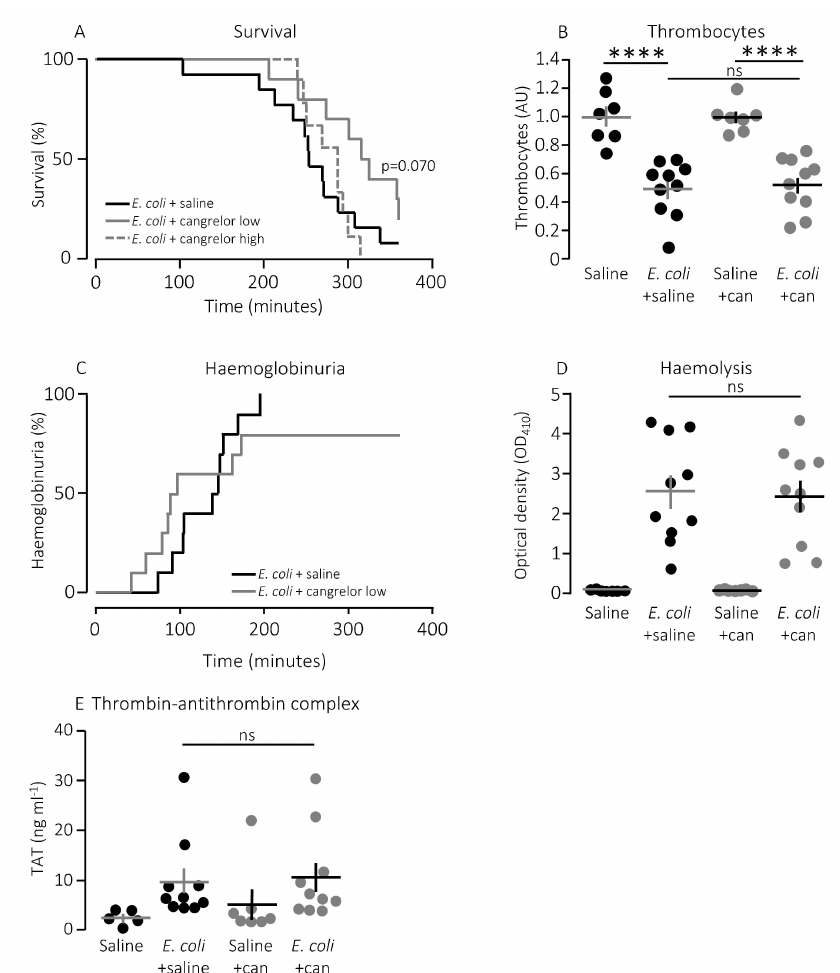
Figure 5. The effect of P2Y 12 receptor antagonist cangrelor (can) in mice with sepsis. ( A ) Mice with bacteraemia receiving continuous infusion of either saline ( n = 13) or cangrelor (8.6 µ g / h, n = 10 or 86.0 µ g / h, n = 9) for up to 6 h. The mice subjected to bacteraemia received 30 x 10 6 E. coli (WAM1824) iv. Data are shown as Kaplan–Meyer plot. ( B ) The relative number of thrombocytes 2.5 h after injection of 30 × 10 6 E. coli iv (saline n = 7, E. coli + saline n = 10, saline + cangrelor (8.6 µ g / h) n = 7, E. coli + cangrelor (8.6 µ g / h) n = 10) ( C ) development of haematuria in mice exposed to 30 × 10 6 E. coli for up to 6 h and infused with either saline ( n = 13) or the P2Y 12 receptor antagonist cangrelor (8.6 µ g / h, n = 10) for op to 6 h. ( D ) Degree of intravascular haemolysis after exposure to 30 × 10 6 E. coli for 2.5 h (saline n = 7, E. coli + saline n = 10, saline + cangrelor (8.6 µ g / h) n = 7, E. coli + cangrelor (8.6 µ g / h) n = 10). ( E ) The intravascular formation of thrombin–antithrombin complexes (saline n = 7, E. coli + saline n = 10, saline + cangrelor (8.6 µ g / h) n = 7, E. coli + cangrelor (8.6 µ g / h) n = 10). The data are given as single observations and mean ± S.E.M, **** p <